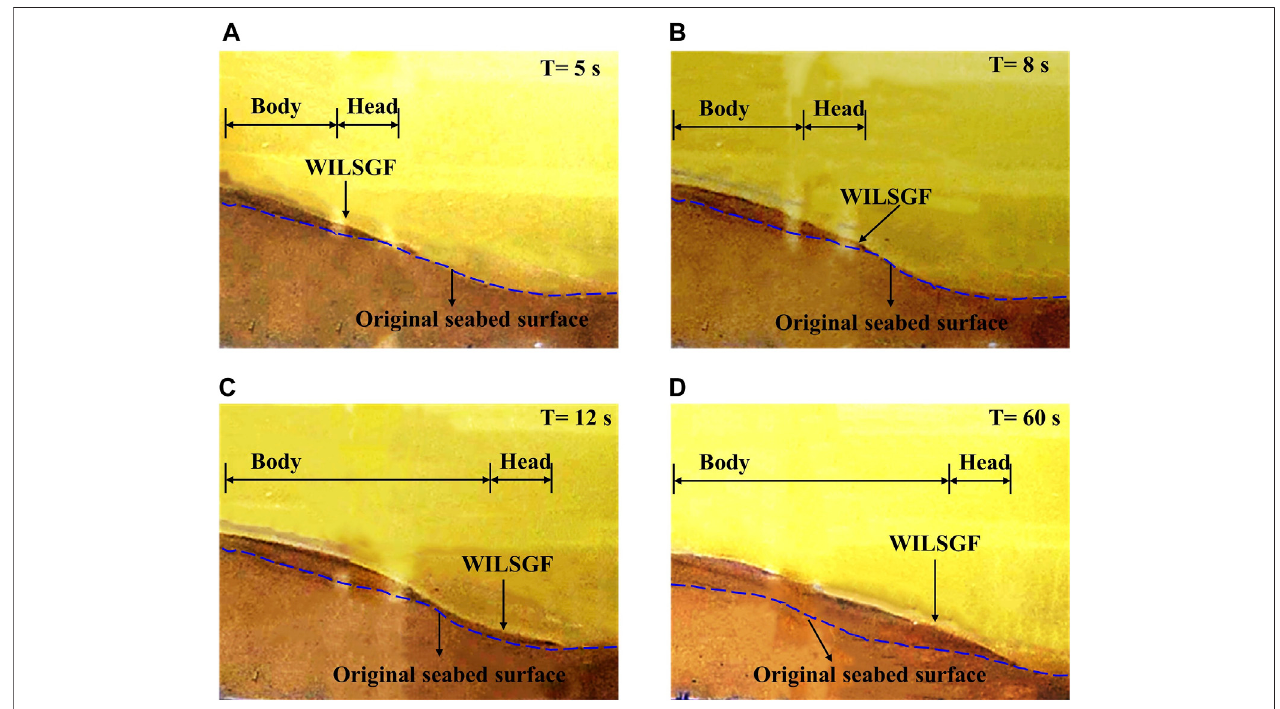
FIGURE 6 | Ongoing process of the WILSGF and the resulting morphological changes at 5, 8, 12, and 60 s in panels (A – D) , respectively.